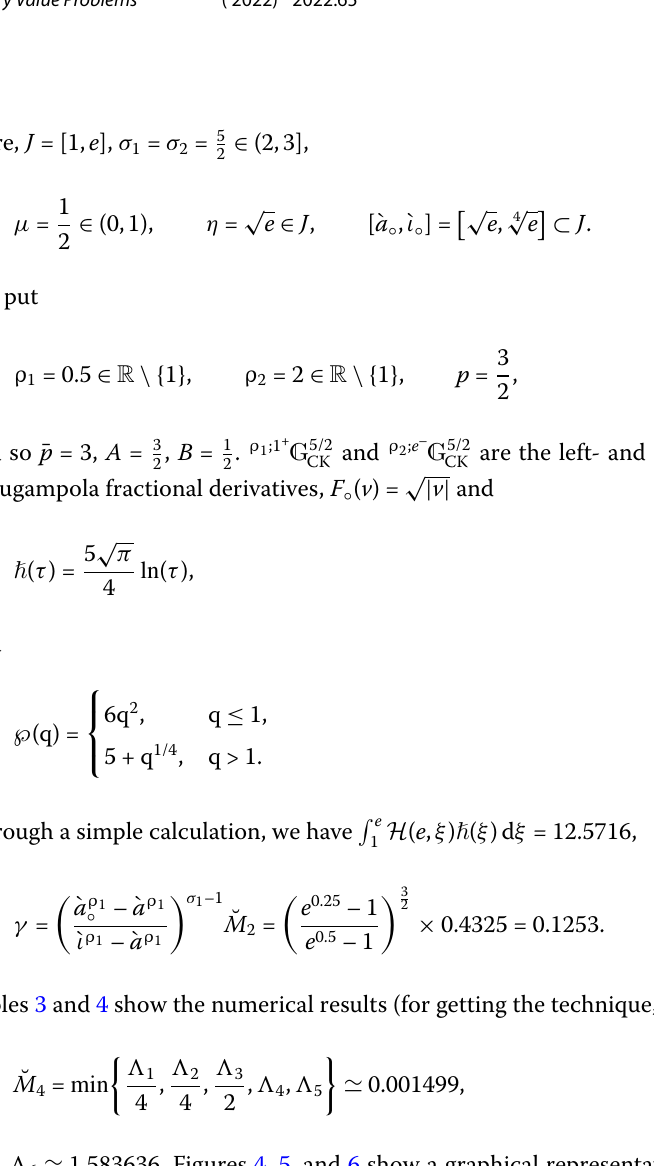
(cid:25) ` ι ` ι , ξ ) d ξ , G 2 ( ` a